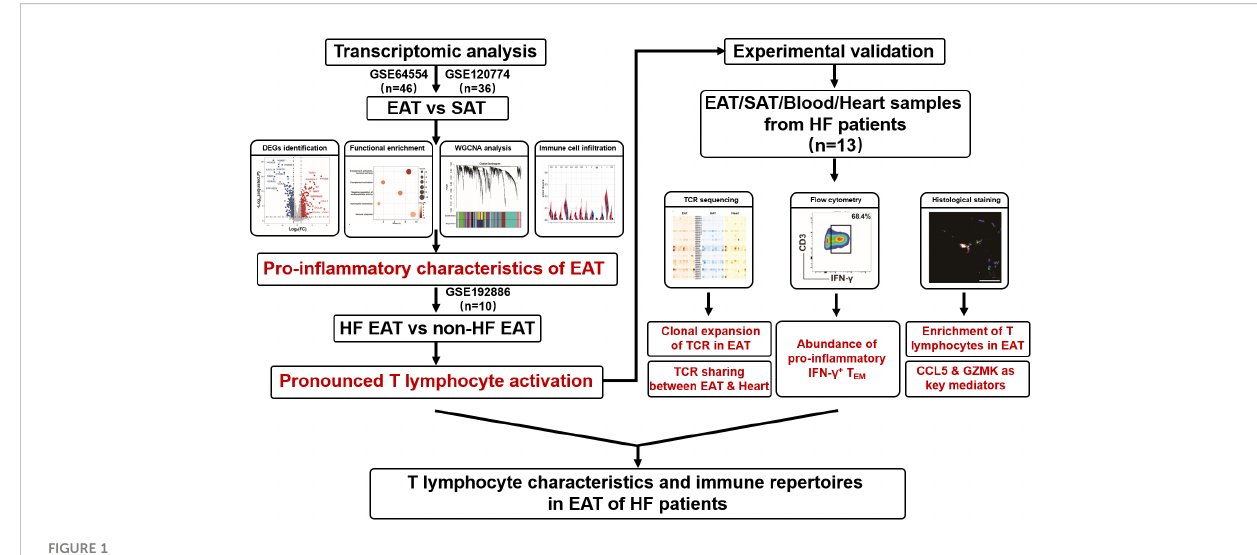
FIGURE 1 Overall fl owchart of this